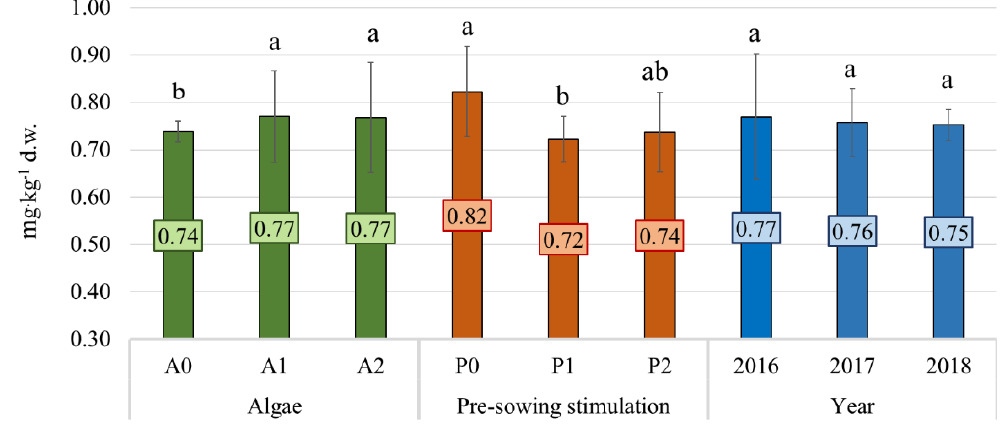
Figure 11. The mean molybdenum content (mg ⋅ kg −1 ) in oat grains in 2016–2018 depending on the experimental factors used. According to Tukey’s HSD test, the means marked with the same letter are not significantly different at α ≤ 0.05.